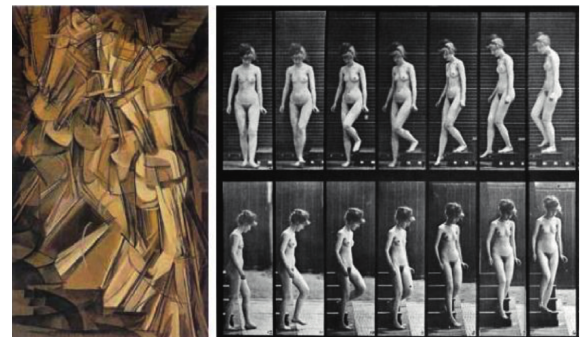
Figure 5: Nude descending the staircase (1912) by Marcel Duchamp; woman descending the staircase (1891) by Eadweard Muybridge